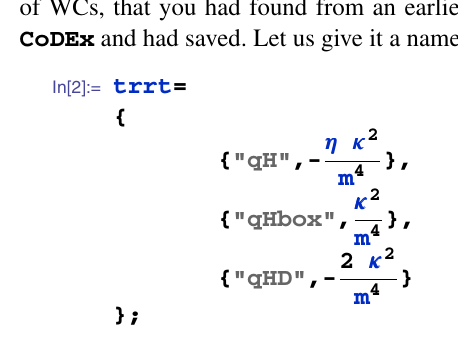
If left blank, will give the tree-level All The level at which output is evaluated ‘ All ’ means the result calculates both tree and loop level results and combines them True Turns the ‘Integration by Parts’ option on Detail available on the loopOutput